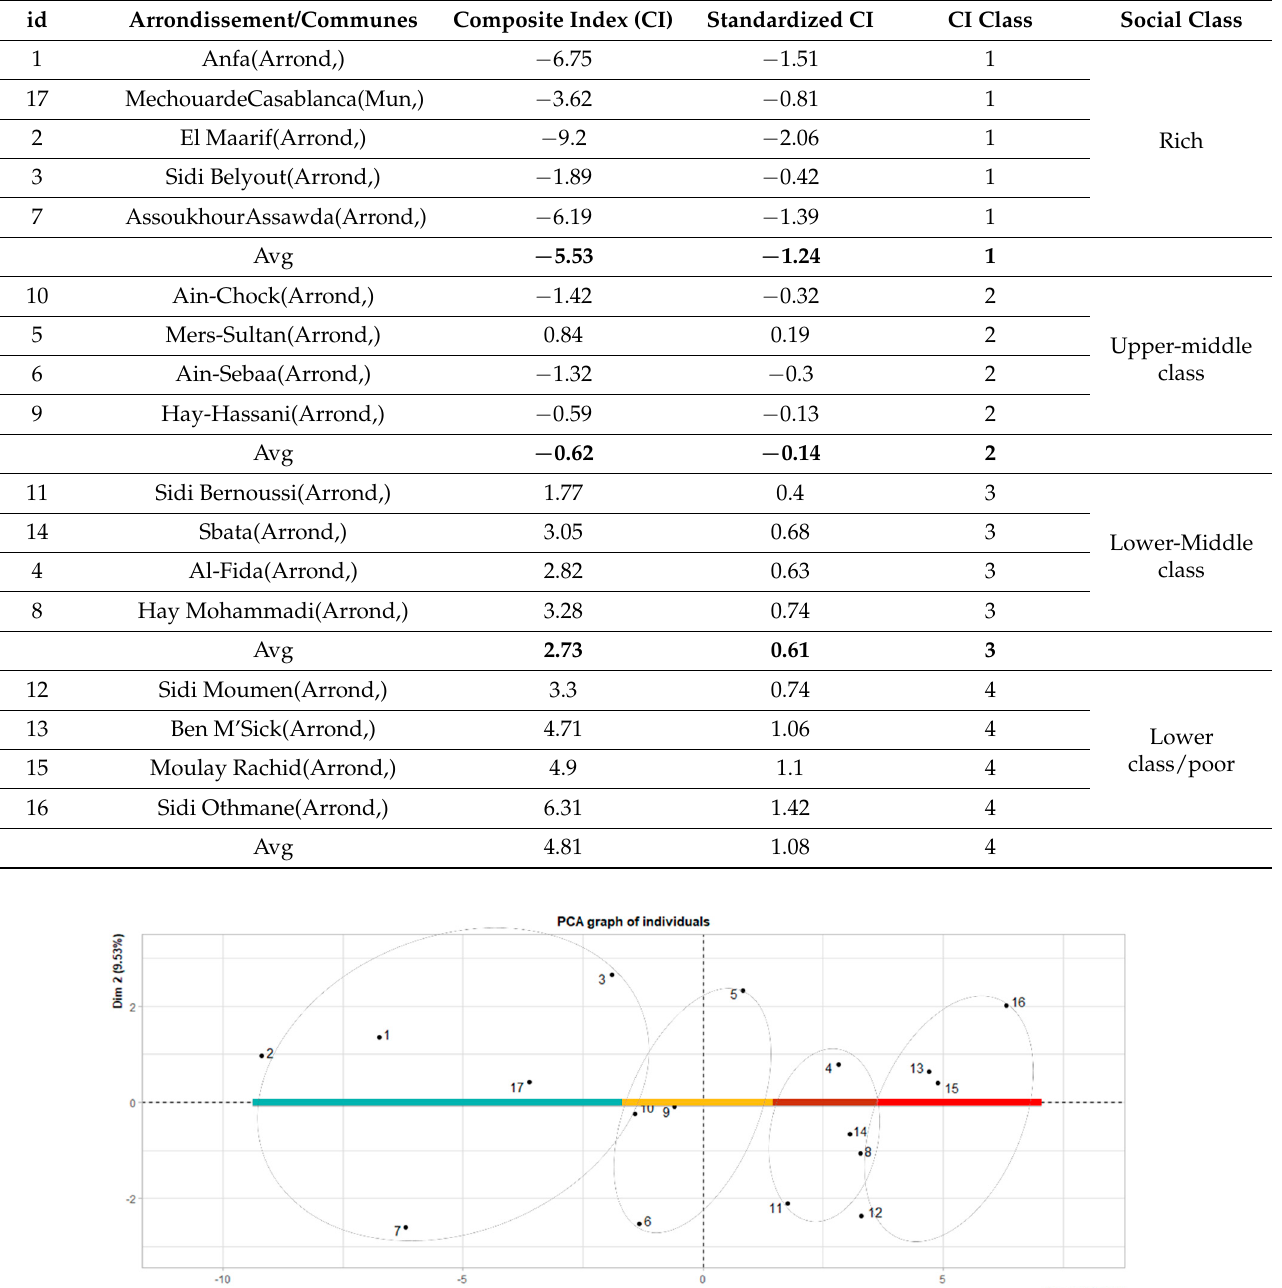
Table 3. Composite index by geographic unit and by social class.